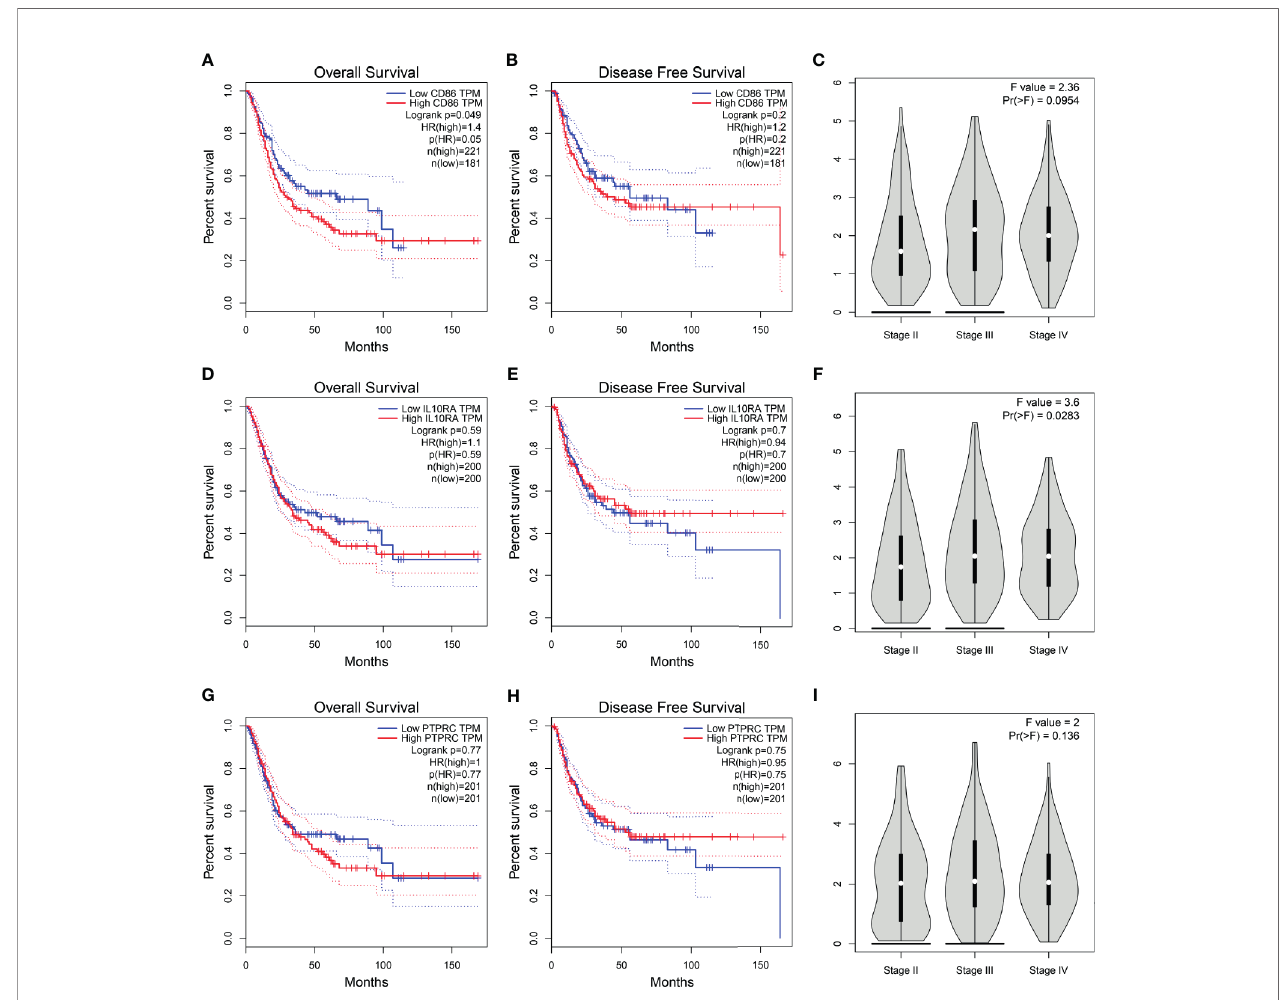
FIGURE 5 | (A) Survival analysis of the association between the CD86 expression level and overall survival time in BC (based on GEPIA). (B) Survival analysis of the association between the CD86 expression level and disease-free survival time in BC (based on GEPIA). (C) stage plot of CD86 by using GEPIA. (D) Survival analysis of the association between the IL10RA expression level and overall survival time in BC (based on GEPIA). (E) Survival analysis of the association between the IL10RA expression level and disease-free survival time in BC (based on GEPIA). (F) stage plot of IL10RA by using GEPIA. (G) Survival analysis of the association between the PTPRC expression level and overall survival time in BC (based on GEPIA). (H) Survival analysis of the association between the PTPRC expression level and disease- free survival time in BC (based on GEPIA). (I) stage plot of PTPRC by using